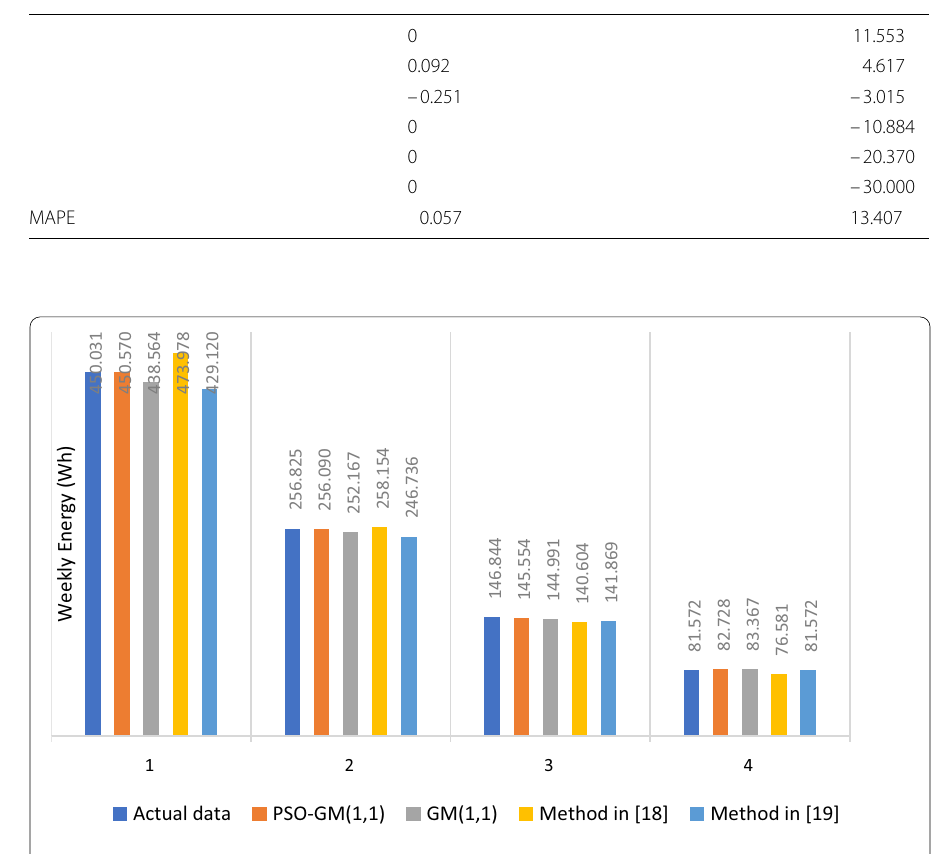
Fig. 4 Forecast results for energy data for a laptop, using the various